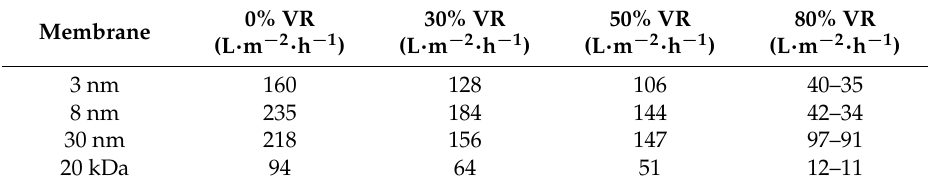
Table 4. The flux through ceramic membranes given a feed volume reduction (VR) of 0%, 30%, 50% or 80%. Process parameters: Re = 12,720, transmembrane pressure = 3 bar, and temperature = 60 ◦ C. The fluxes region at a VR of 80% results from different VR at one fed-batch experiment. Due to the experimental setup it was not possible to achieve at every experiment a VR of 80% within the first